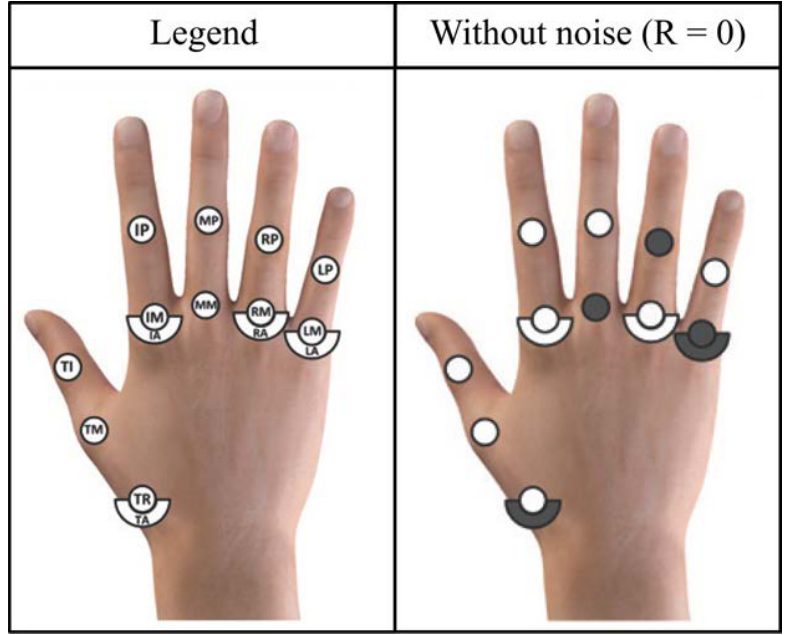
Figure 3. Measured joints (highlighted in color on the right) for the optimal design of a glove with five sensors, with R = 0 ( cf. Figure 2). These joints were selected from the results obtained in